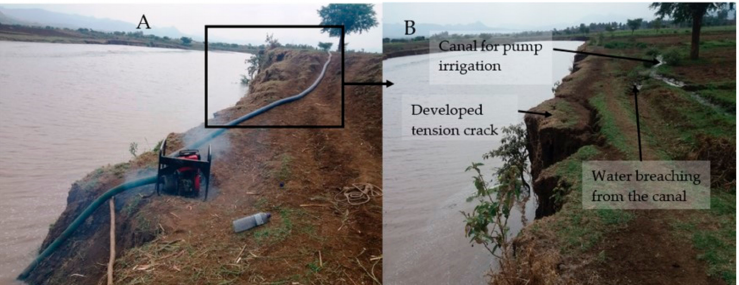
Figure 9. ( A ) water extraction with a diesel pump for irrigation; ( B ) irrigation canal to transport extracted water, which has been breached, and adjacent failing banks. The photos were taken immediately upstream of the under-construction Ribb weir in April